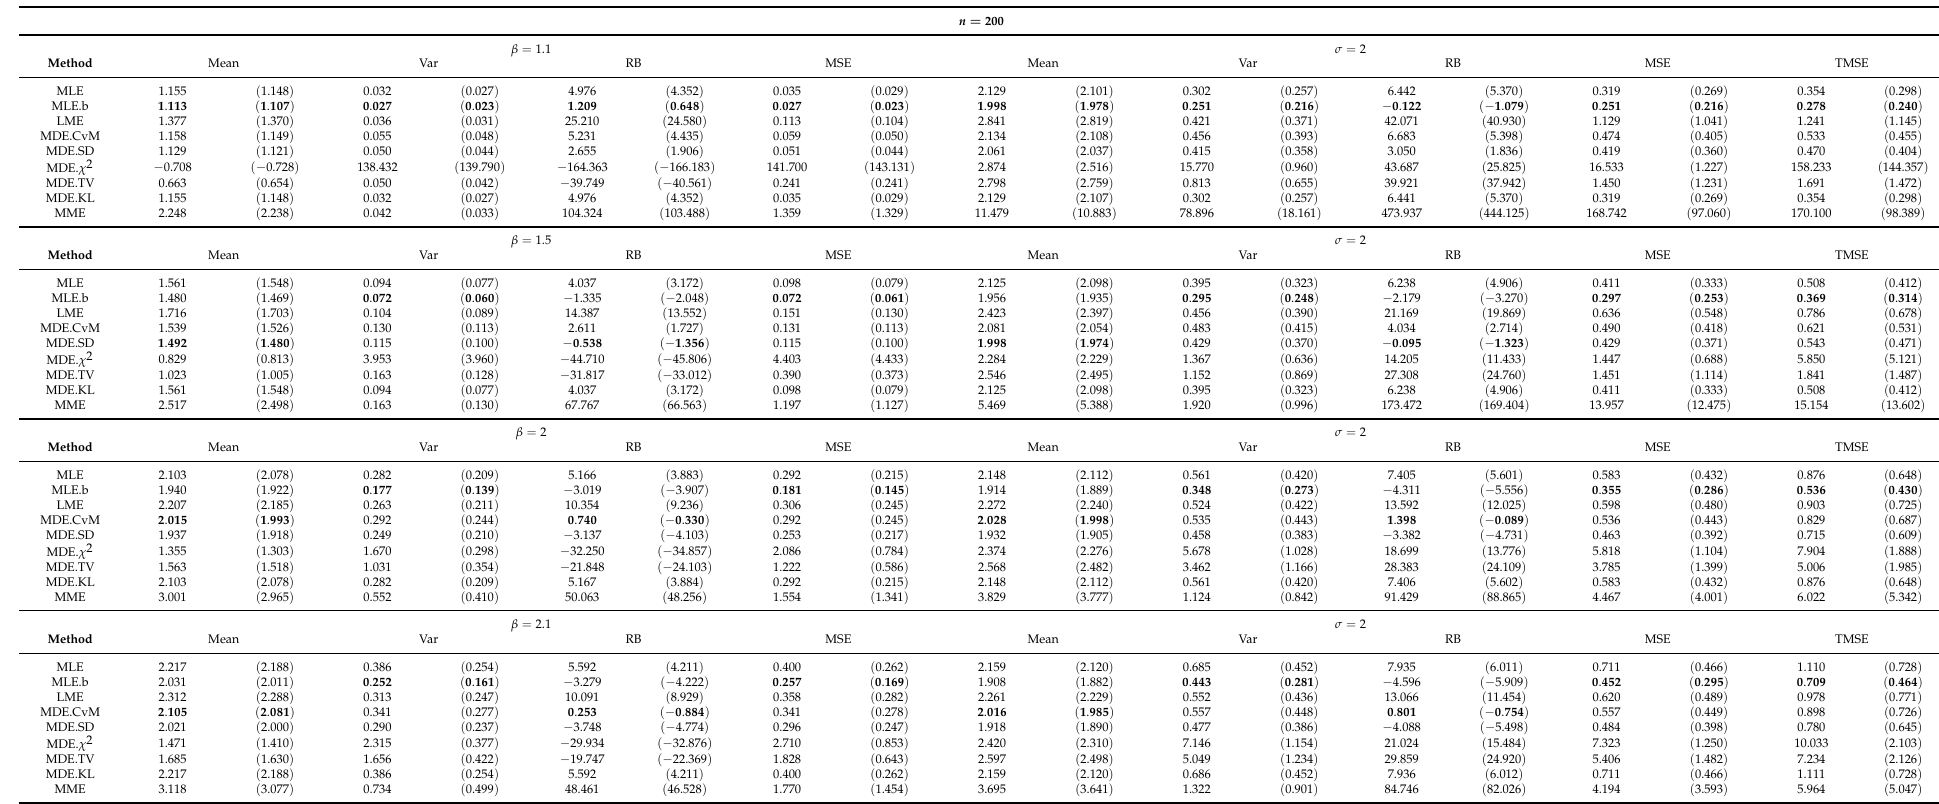
Table A4. Comparison of different estimation methods for different values of β ( σ = 2 and n =